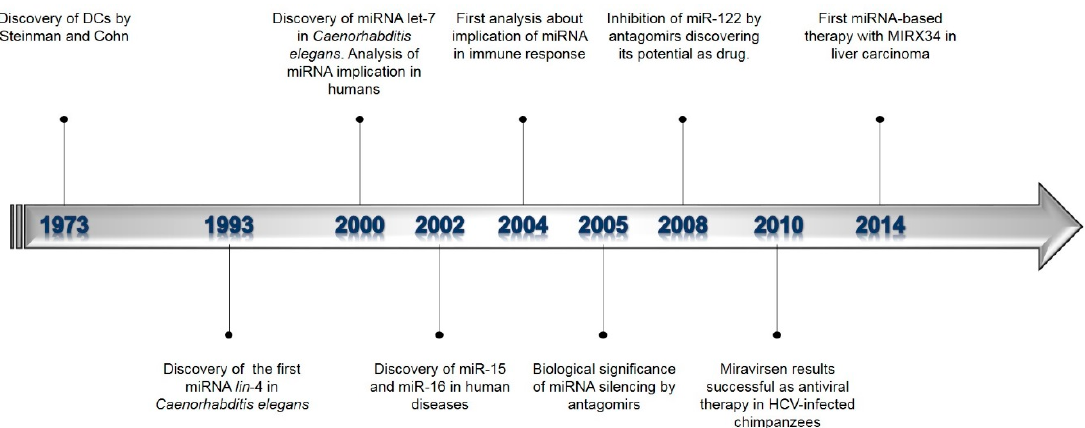
Figure 2. Timeline representing the main milestones of microRNAs (miRNAs) and dendritic cells (DCs) discoveries, highlighting the more significant evidence of miRNAs in immune response and therapy.